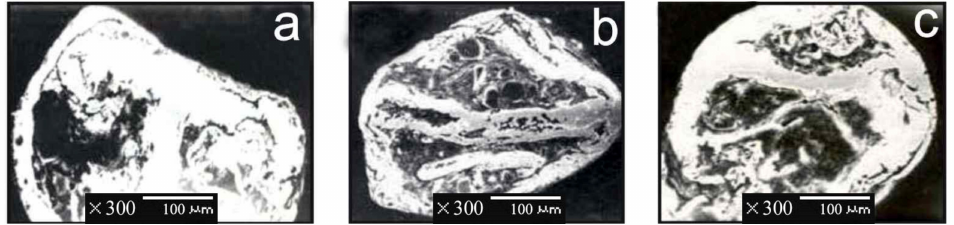
Figure 13. Cross-sections of various forms of hollow gold from natural: ( a ) internal partition; ( b ) filamentous twisted gold; ( c )